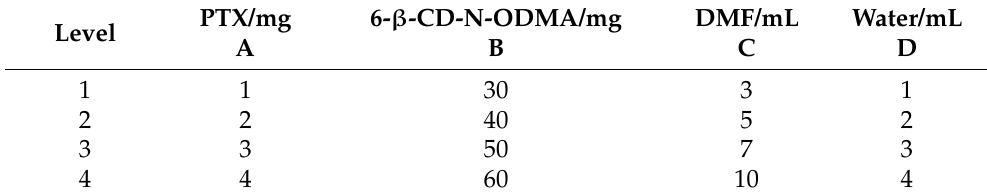
Table 1. Factors and levels for orthogonal